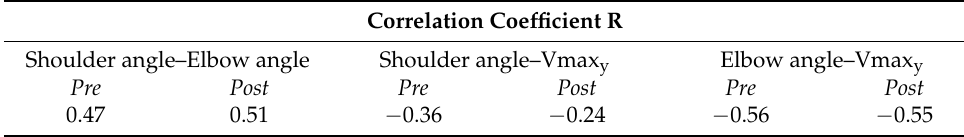
Table 2. Spearman correlation coefficient R among joint kinematic angles and